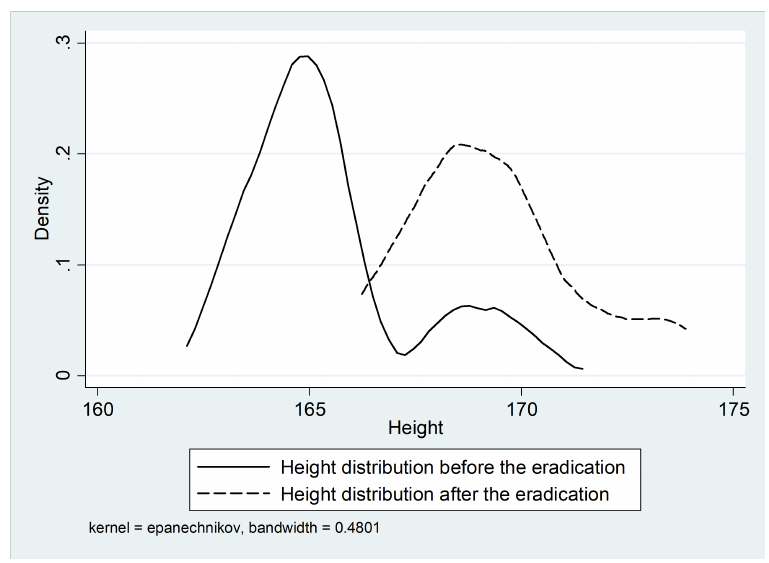
Figure 3: Change in height distribution in regions with high malaria mortality